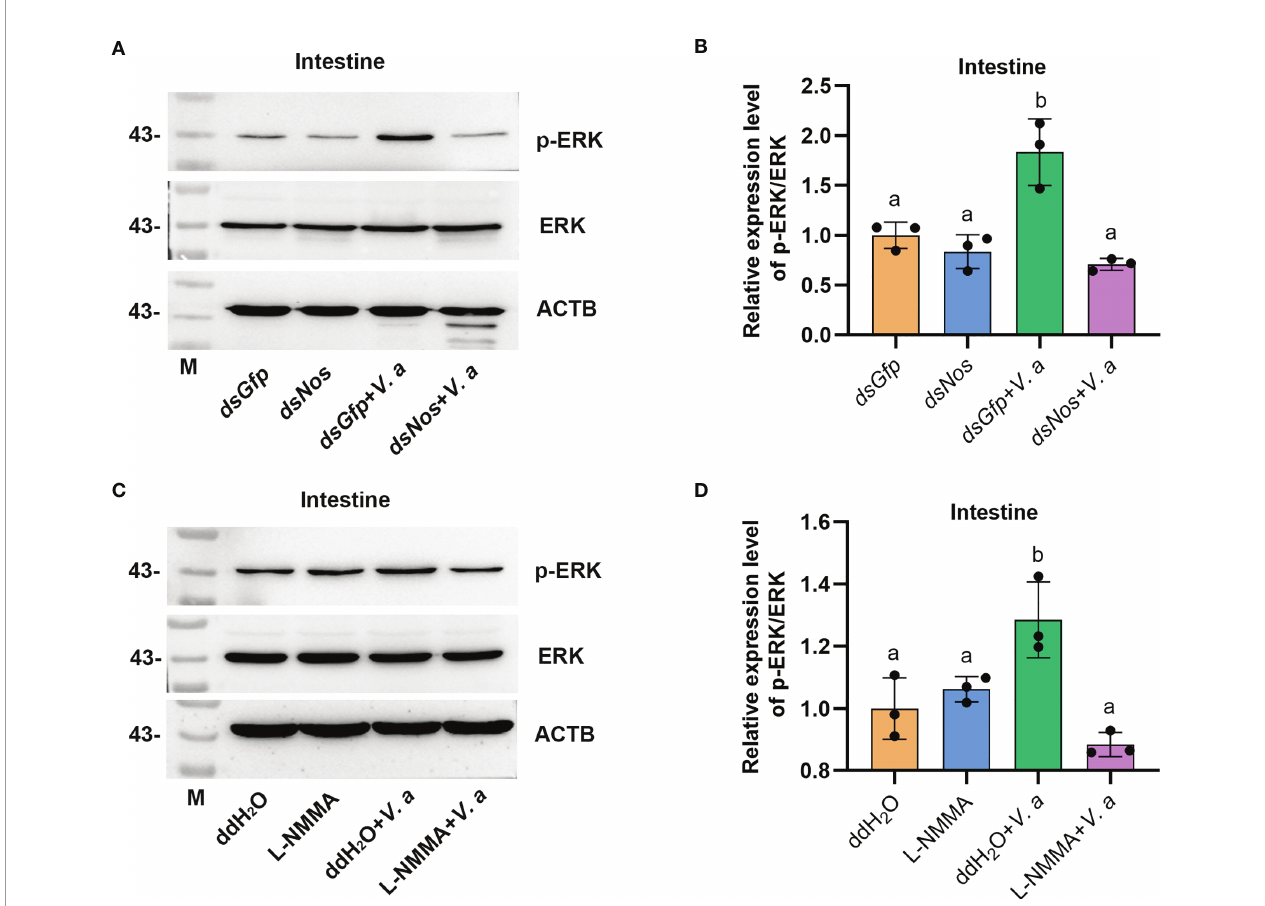
FIGURE 7 | Increased NO level promotes ERK phosphorylation in shrimp challenged by V. anguillarum . (A) The level of p-ERK was analyzed by western blotting after Nos RNAi; dsGfp injection was used as the control, and ACTB ( b -actin) and ERK were used as the loading control. (B) Statistical analysis of the data shown in (A) using ImageJ. Relative expression levels of ERK/ACTB were expressed as the mean ± SD, and the value of the control shrimp was set as 1. (C) The levels of p-ERK and ERK in shrimp after L-NMMA and V. anguillarum treatment; ddH 2 O was used as the control, and ACTB and ERK were used as the loading control. (D) Statistical analysis of the data shown in (C) using same method as in (B) . One-way ANOVA was used for multiple comparisons, the different lowercase letters indicate signi fi cant differences ( p < 0.05) in the ANOVA